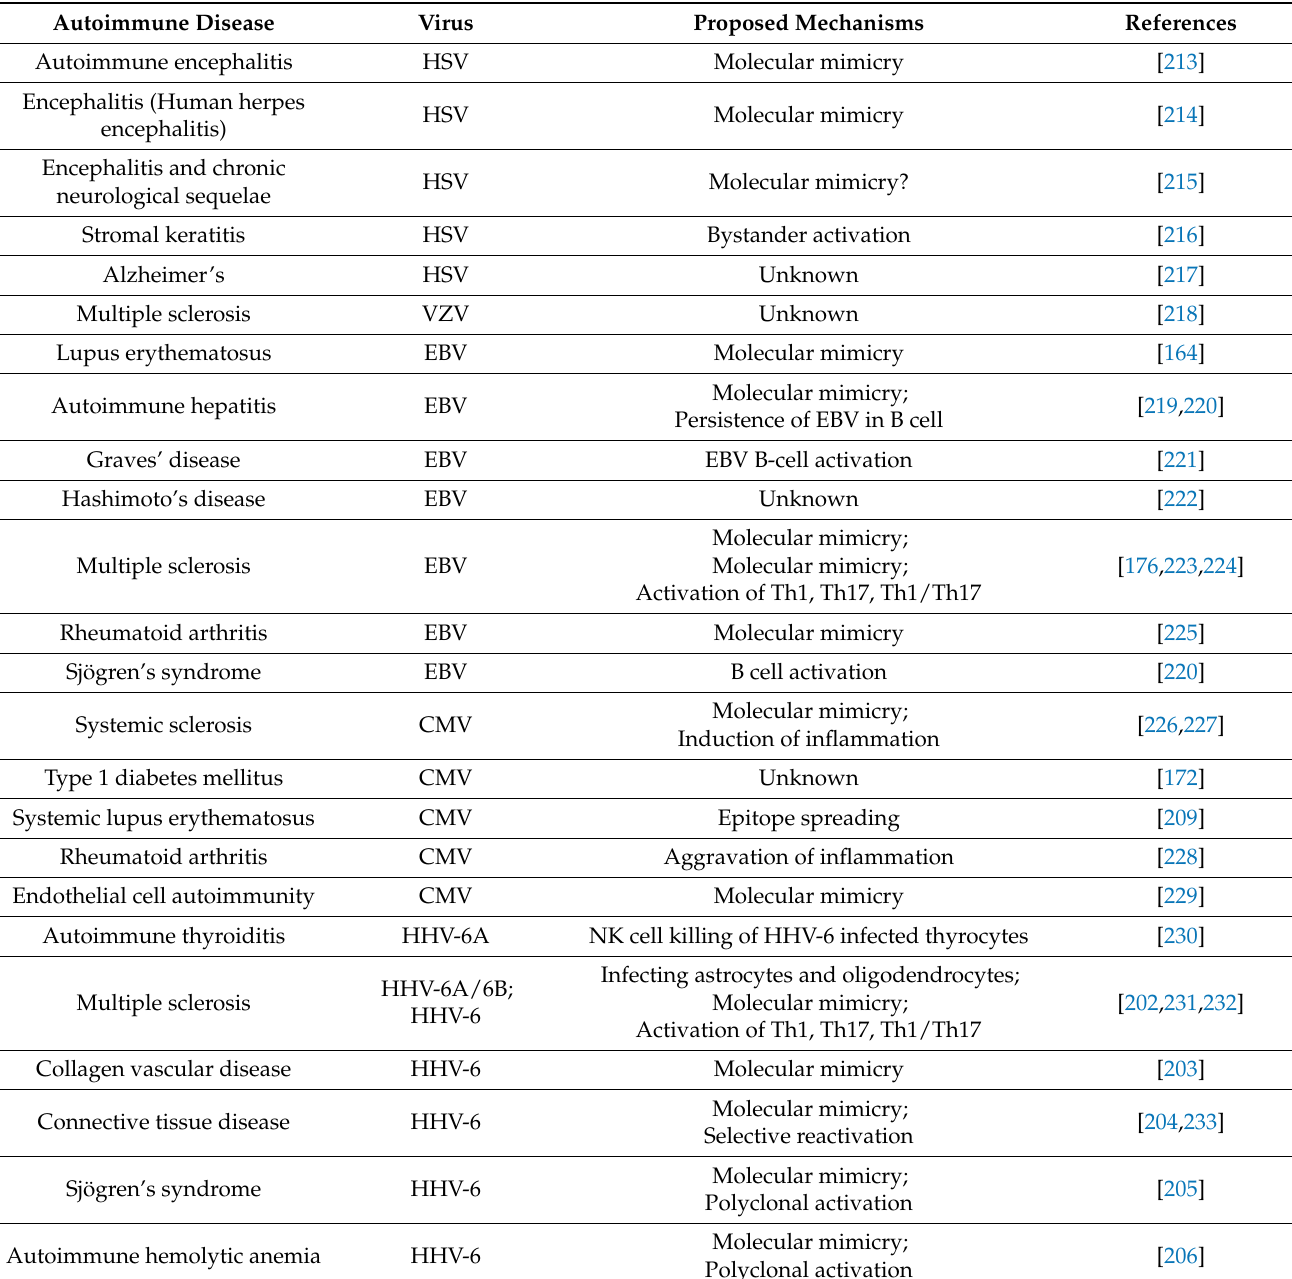
Table 4. Viruses, autoimmune diseases, and proposed mechanisms of